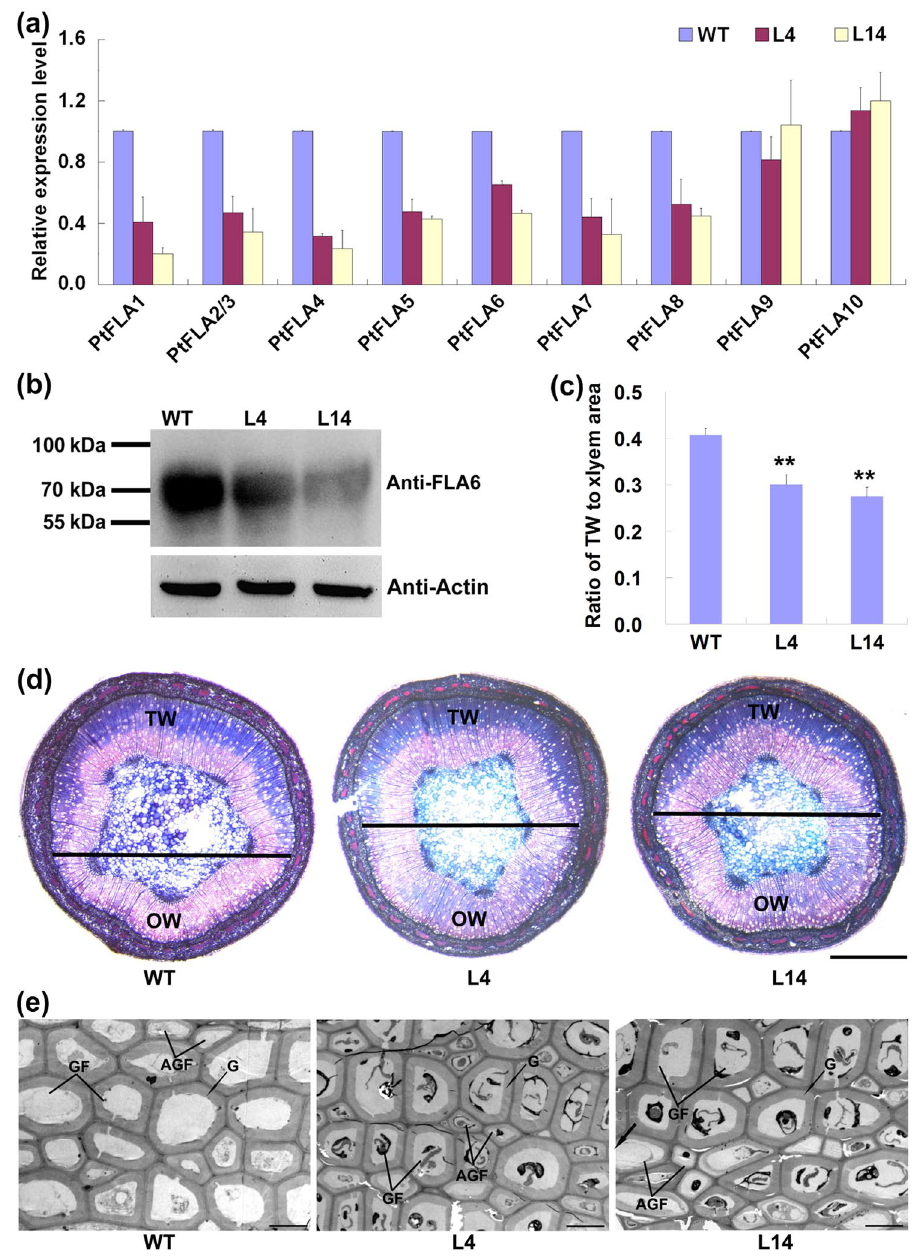
Figure 4. TW formation was inhibited in PtFLA6 antisense transgenic plants. ( a ) Expression analysis of PtFLAs in the transgenic TW xylem. The expression of PtFLAs in the TW xylem of WT was set to 1. Error bars represent SDs from three biological replicates. ( b ) Western blotting analysis of PtFLA6 protein in the transgenic TW xylem. An amount of 30 μ g proteins were separated by 10% SDS-PAGE and hybridized with PtFLA6 antibodies (Anti-FLA6) or plant actin antibodies (Anti-Actin), respectively. WT, wild type; L4 and L14, transgenic lines 4 and 14. ( c ) Ratio of TW area in the xylem area of transgenic plants. Error bars represent the SDs from five plants. ** Indicates significant difference in comparison to WT at P < 0.01 (Student’s t-test). ( d ) Histochemical staining analysis of TW formation in transgenic plants. The horizontal line indicates the division between TW side and OW side. TW, tension wood; OW, opposite wood. Scale bars = 1 mm. ( e ) Transmission electron micrographs of G-fibers in transgenic TW. More AGF were present in transgenic TW. GF, G-fiber; AGF, abnormal G-fiber with stunted G-layer production; G, G-layer. Scale bars = 10 μ